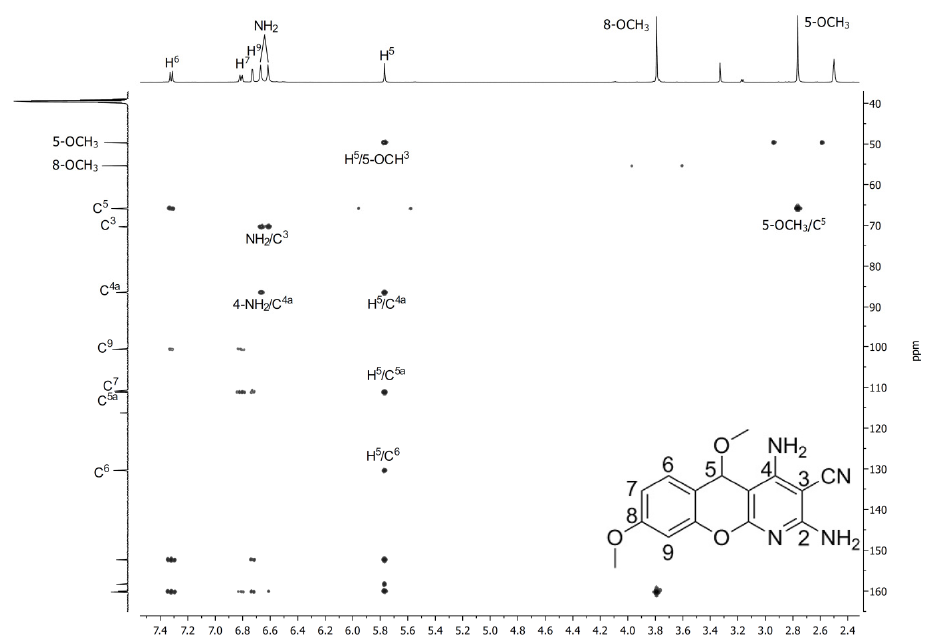
Figure 4. 1 H- 13 C HMBC NMR spectrum of 2,4-diamino-5,8-dimethoxy-5 H -chromeno[2,3- b ]pyridine- 3-carbonitrile 4d in DMSO- d 6 (400 MHz, 298